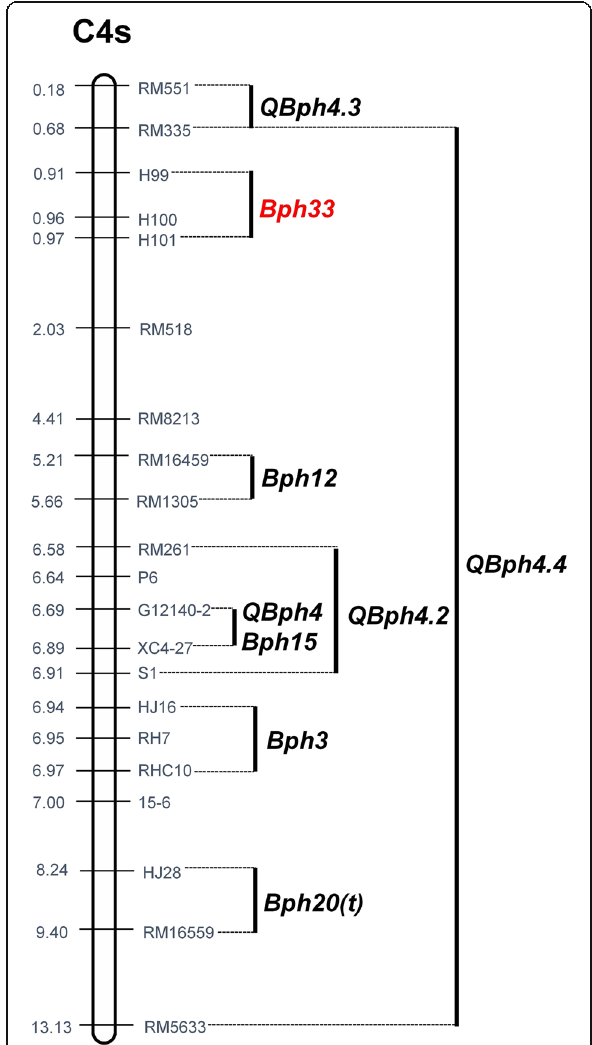
Fig. 7 Locations of all BPH genes or QTLs around Bph33 on the short arm of chromosome 4. Data from Qiu et al. (2012), Lv et al. (2014), Hu et al. (2015a, b), Mohanty et al. (2017), Liu et al. (2015) and Rahman et al.